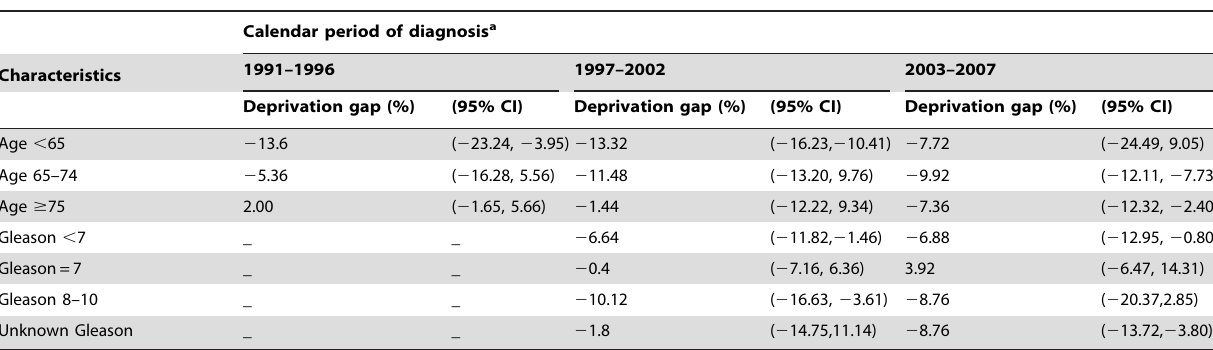
Table 4. Deprivation gap in 5-year relative survival of prostate cancer patients by age, Gleason grade and calendar period in the West of Scotland during